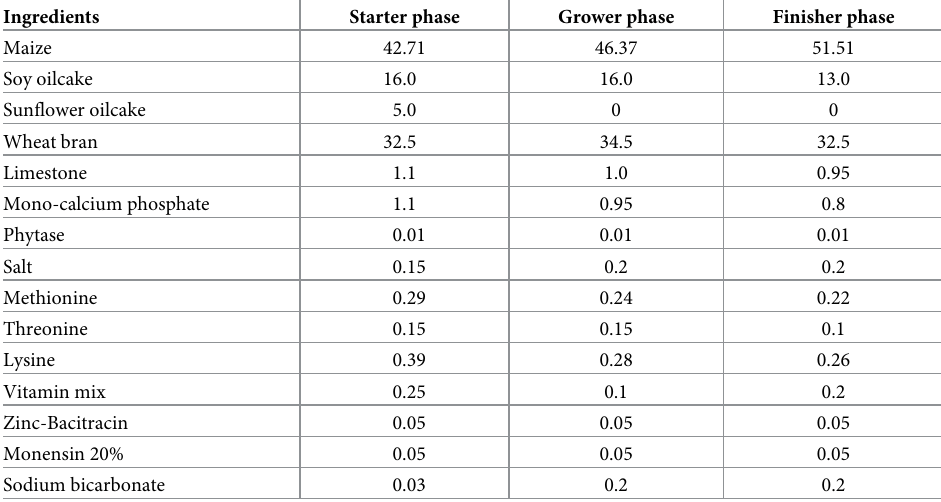
Table 1. Ingredient composition (%, as fed basis) of experimental starter, grower, and finisher phase diets.